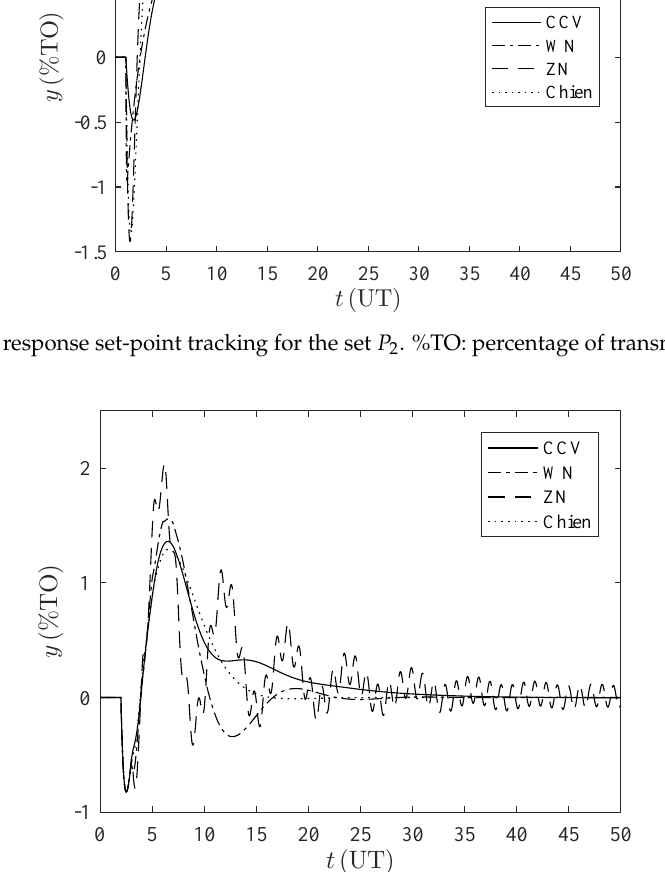
Figure A5. Time response disturbance rejection for the set P 3 . %TO: percentage of transmitter output, UT: units of time.